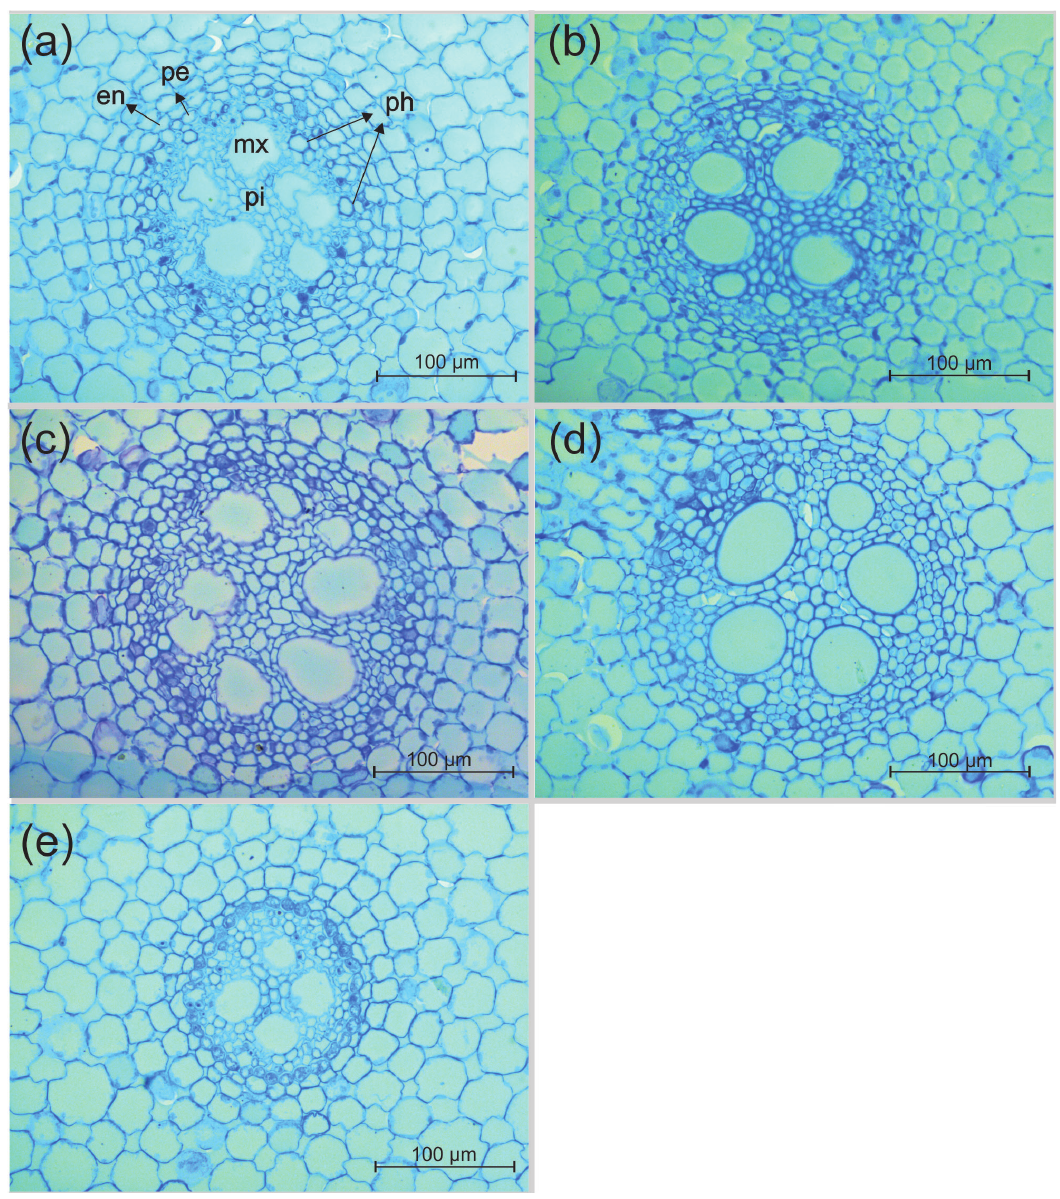
Figure 5. Anatomical modifications of T. domingensis vascular cylinder developed under different phosphorus levels on the nutrient solution. (a)= 0.0; (b) = 0.2; (c) = 0.4; (d) = 0.6; (e) = 0.8 mM of phosphorus. en = endodermis, pe = pericycle, pi = pith, mx = metaxylem, ph =